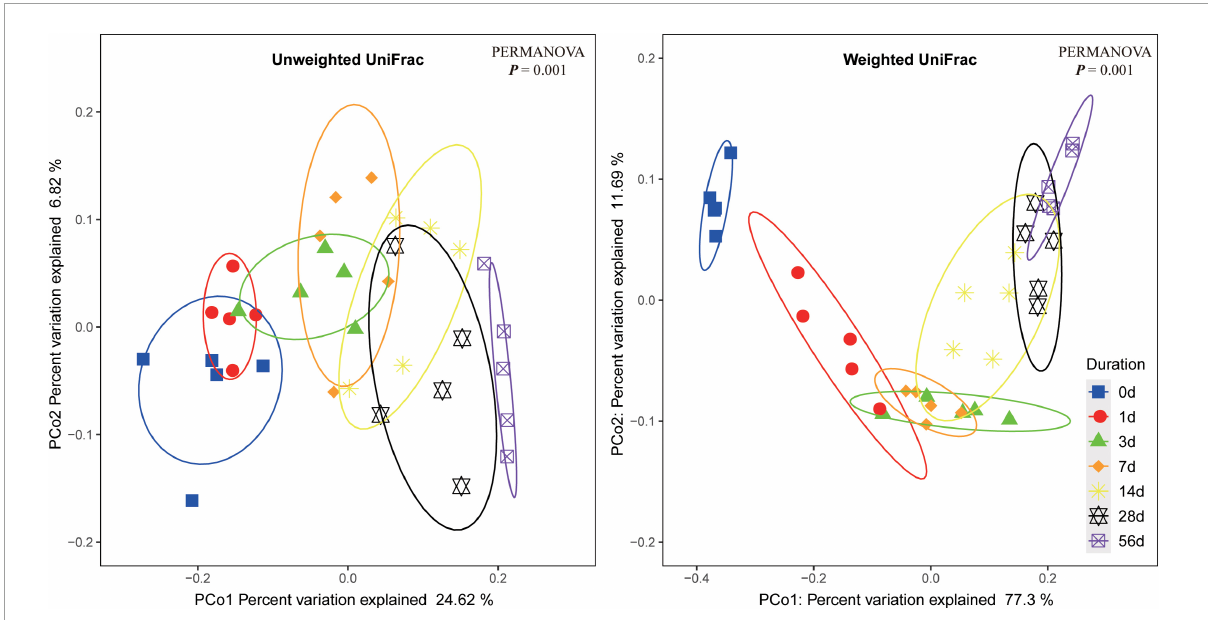
FIGURE1 Dissimilarity of the bacterial profiles in sorghum stalk silage at different ensiling duration. Distance between samples based on similarity in ASVs composition was calculated using unweighted UniFrac (left) and weighted UniFrac distance (right), and visualized using PCoA plots. The impact of ensiling duration on the clustering pattern of bacterial communities was tested using PERMANOVA. The ovals in varied colors represent 95% confidence interval of silage bacterial profiles at different ensiling